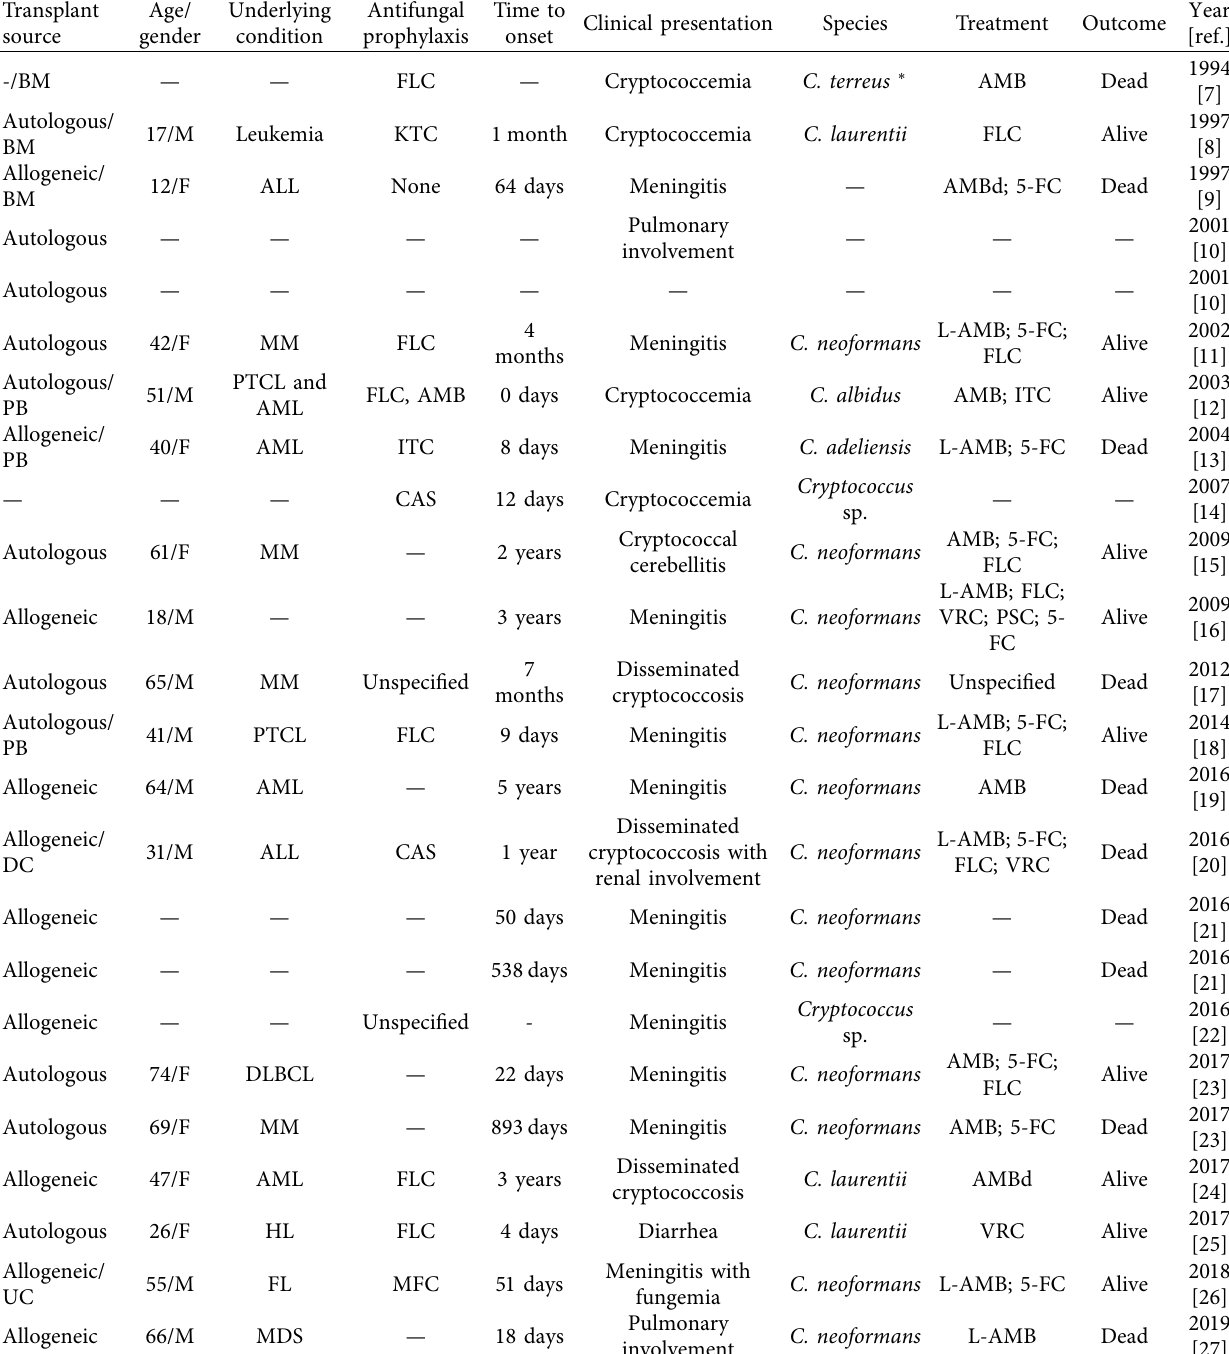
Table 1: Reported cases of hematopoietic stem cell transplant recipients with